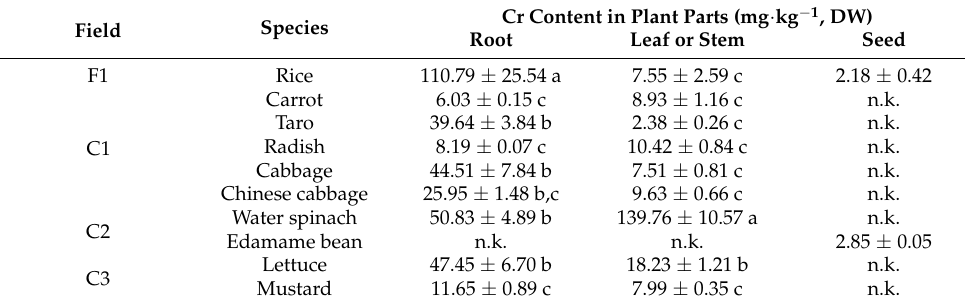
Table 3. Cr content in different parts of crops and